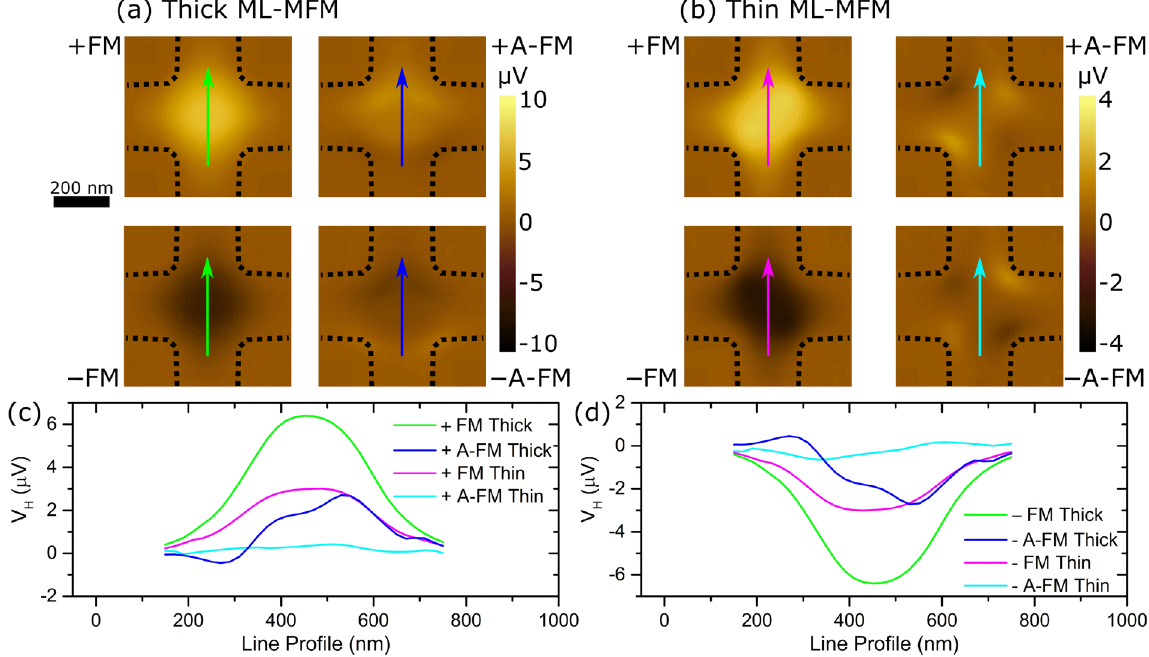
Figure 7. Simulated mSGM maps of local Hall voltage. Simulated mSGM images for ( a ) thick and ( b ) thin ML-MFM probes in the FM ( ↓↓ ) and A-FM states ( ↓↑ ). Top/bottom rows of images in ( a ) and ( b ) are for probes magnetised + / − , respectively. Black dashed lines depict the Hall cross borders. ( c ) and ( d ) are line profiles of the Hall voltage across the lines of the same colour indicated in ( a ) and ( b ) for the probes magnetised in + and − direction,